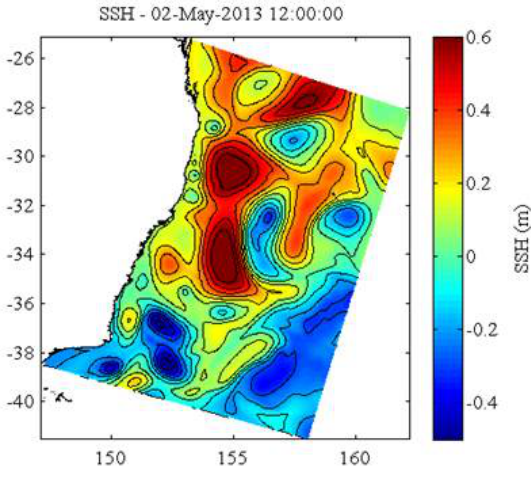
Figure 1. Altimetric map showing the interaction of eddies near the east coast of Australia; notice the close interaction of two anticyclones near the coast (Archiving, Validation and Interpretation of Satellite Oceanographic Data